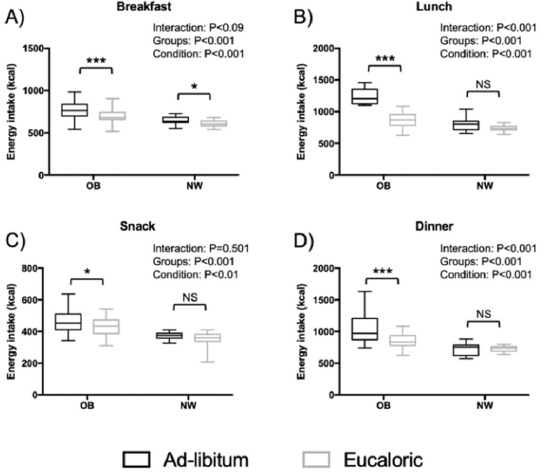
Figure 3. Distribution of energy intake throughout the four meals among adolescents with obesity and their matched normal weight controls during ad libitum and eucaloric sessions. *: significant difference in Post hoc pairwise comparisons (ad libitum vs. eucaloric) with p < 0.05. ***: significant difference in Post hoc pairwise comparisons (ad libitum vs. eucaloric) with p < 0.001.